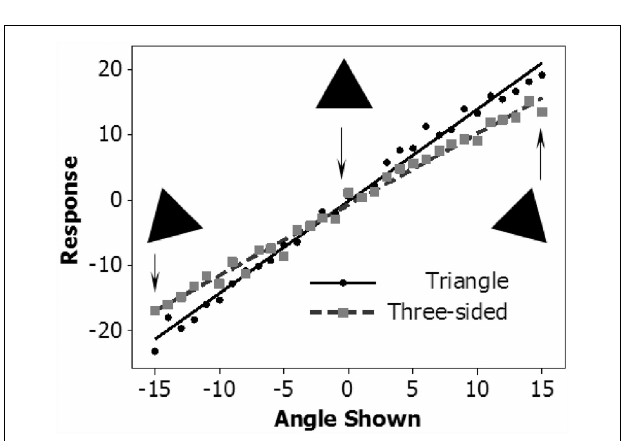
FIGURE 4 |A comparison of judgments of the base angle relative to the horizontal of triangles called “triangles” and the same figures called “three-sided shapes” (Lupyan,